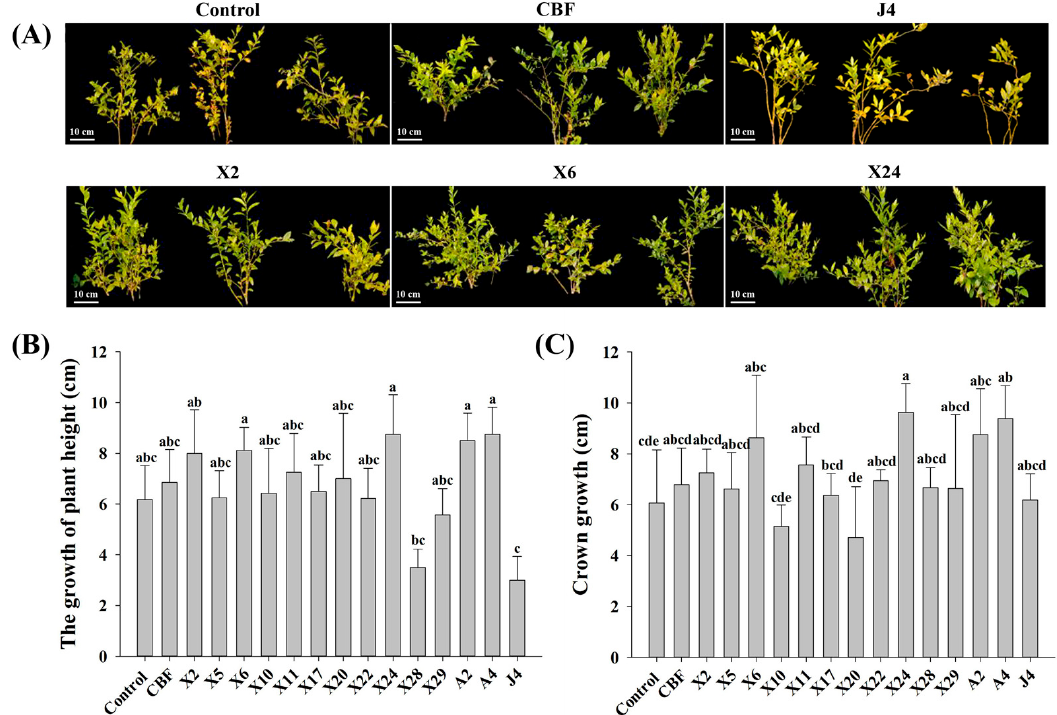
Figure 2. Effects of inoculation with endomycorrhizal fungi on blueberry ( A ) phenotype, ( B ) plant height, and ( C ) crown of blueberries. Representative phenotypes are shown in Figure 2A. Control plants were treated with conventional organic fertilizer with nutrient solution, CBF was treated with commercial bacterial fertilizer, and the remaining treatments were treated with conventional organic fertilizer with nutrient solution, then inoculated with endomycorrhizal fungi isolates. Columns marked with different lowercase letters indicate significant differences ( p < 0.05) between genotypes. Error bars represent the standard error of means ( n = 3).